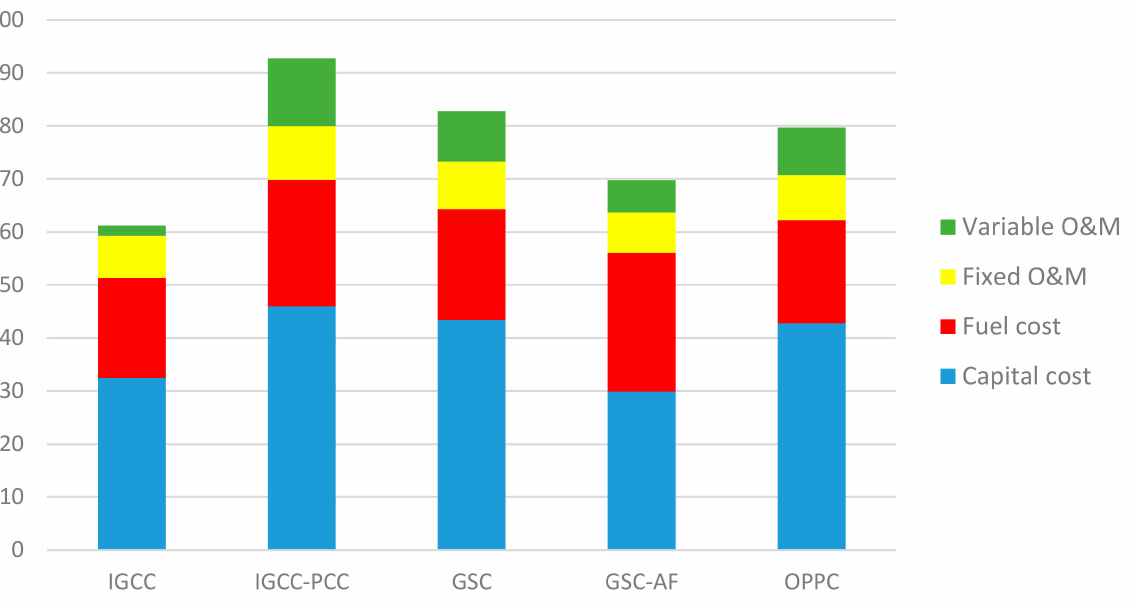
Figure 7. LCOE breakdown for the five IGCC